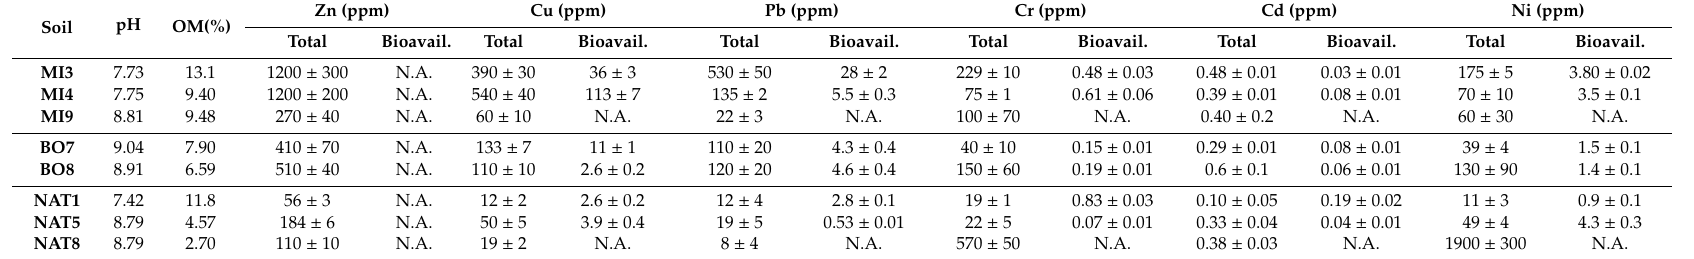
Table 3. Total and bioavailable concentrations of six heavy metals in the analyzed